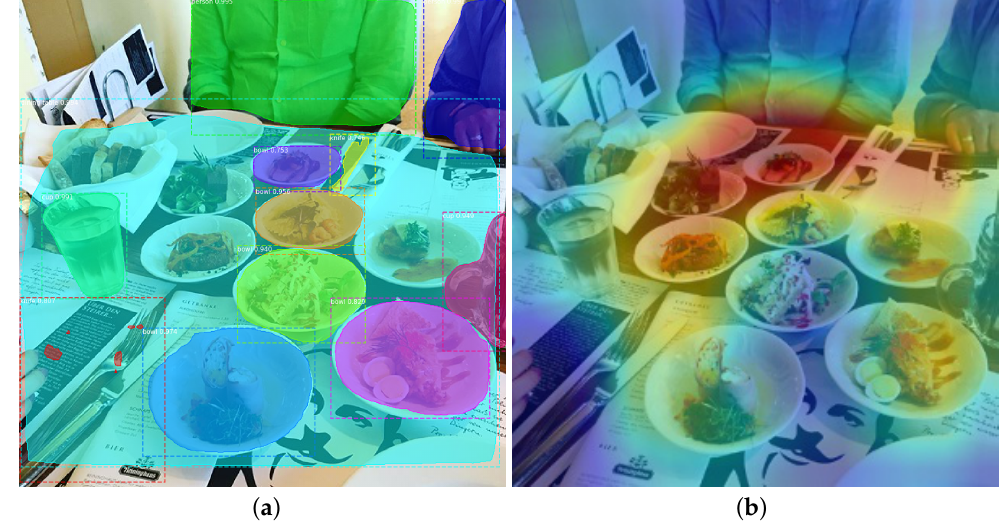
Figure 5. Differences in computer vision techniques applied to the same images; ( a ) uses an object recognition method that person, dining table, cup (2 x ), knife (2 x ), bowl (5 x ), while ( b ) uses a scene recognition one extracting dining hall, cafeteria, and delicatessen